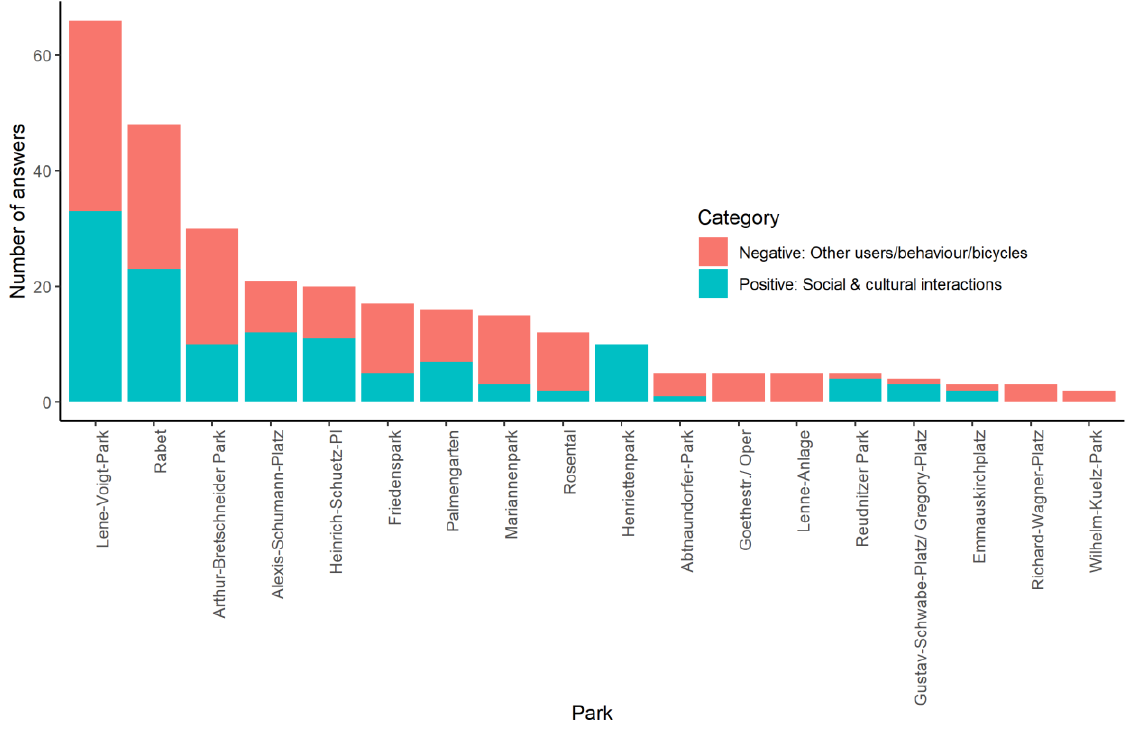
Figure A1.10: Trade-offs between social & cultural interactions as perceived benefits (positive) and people feeling disturbed (negative) by other users and their activities in 18 urban parks (categorized answers from open question).